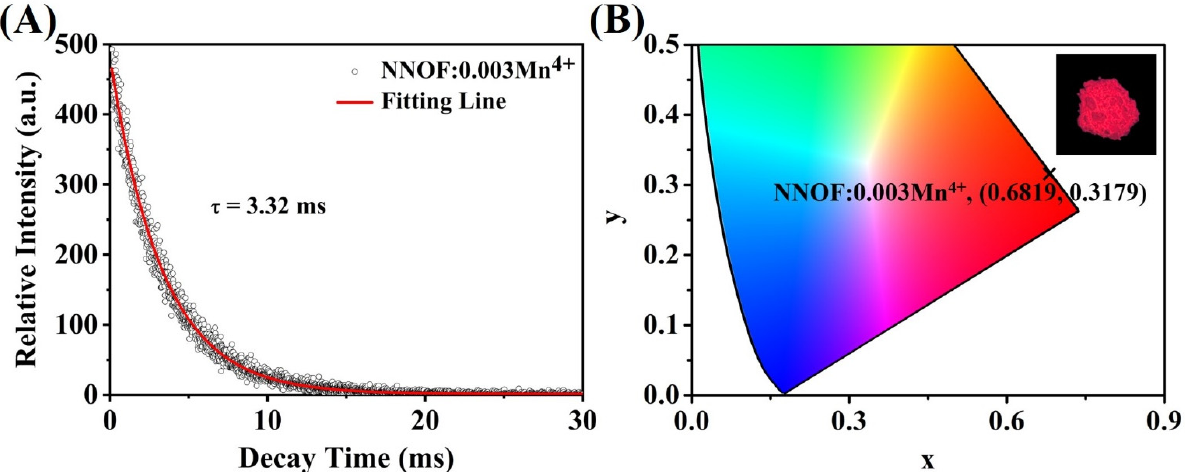
Figure 7. ( A ) Photoluminescence decay curve of NNOF:0.003Mn 4+ ; ( B ) CIE coordinates of the NNOF:0.003Mn 4+ , inset: photo of phosphor illuminated by 365 UV lamp.